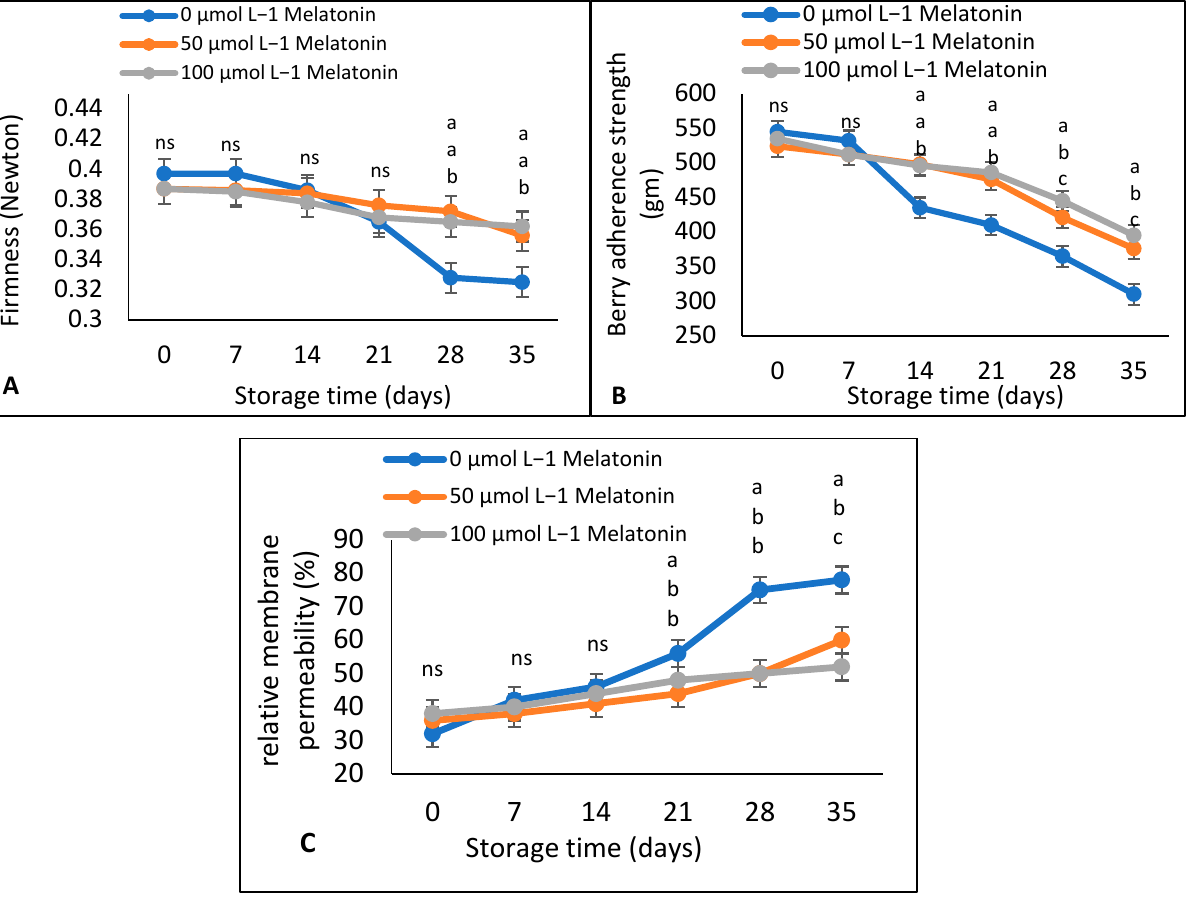
5 of 11 Figure 2. Effect of three concentrations of melatonin on ( A ) weight loss, ( B ) TSS, ( C ) titratable acid- ity, and ( D ) TSS: acids ratio of grape berries stored at 0 °C for 35 days. Values are means ± SE from five replicates ( n = 5). The same letter means no significant differences between the values ( p < 0.05) according to the Tukey test. There were no changes in TA content in grape berries until 21 days of storage (Figure 2C). However, an increase after 28 days was observed and then disappeared. There was no statistical difference between treatments until 14 days of storage. After 28 days, the